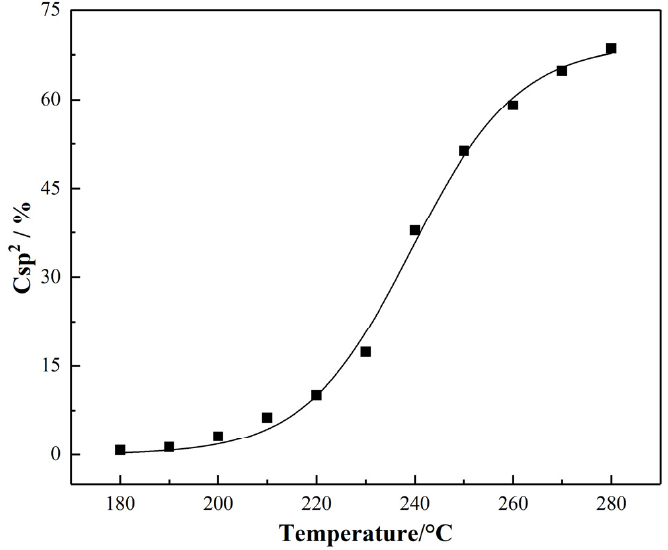
Figure 7. Variety of relative content of sp 2 hybrid carbon atoms of PAN fibers during stabilization.